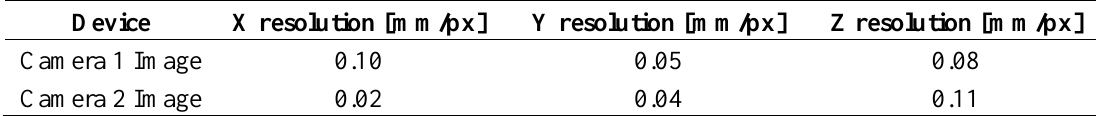
Table 3. Resolution of the images [mm/pixel]. X , Y & Z directions are shown in Figure